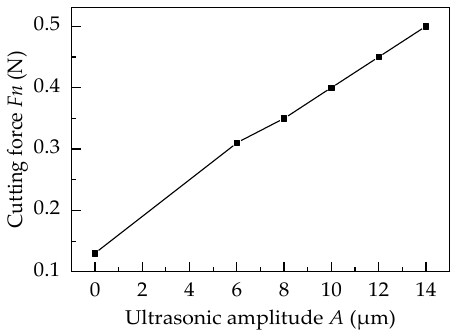
Figure 7. The relationship between cutting force and ultrasonic amplitude.